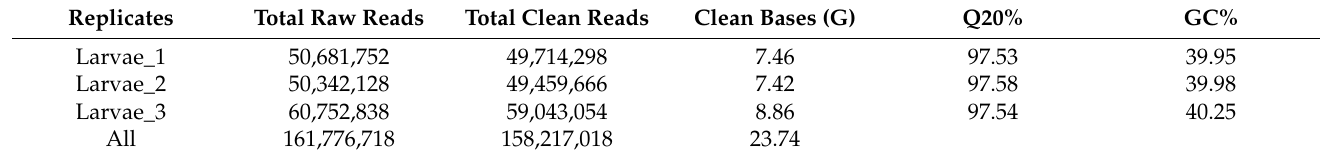
Table 1. Output statistics from D. provosti larvae.